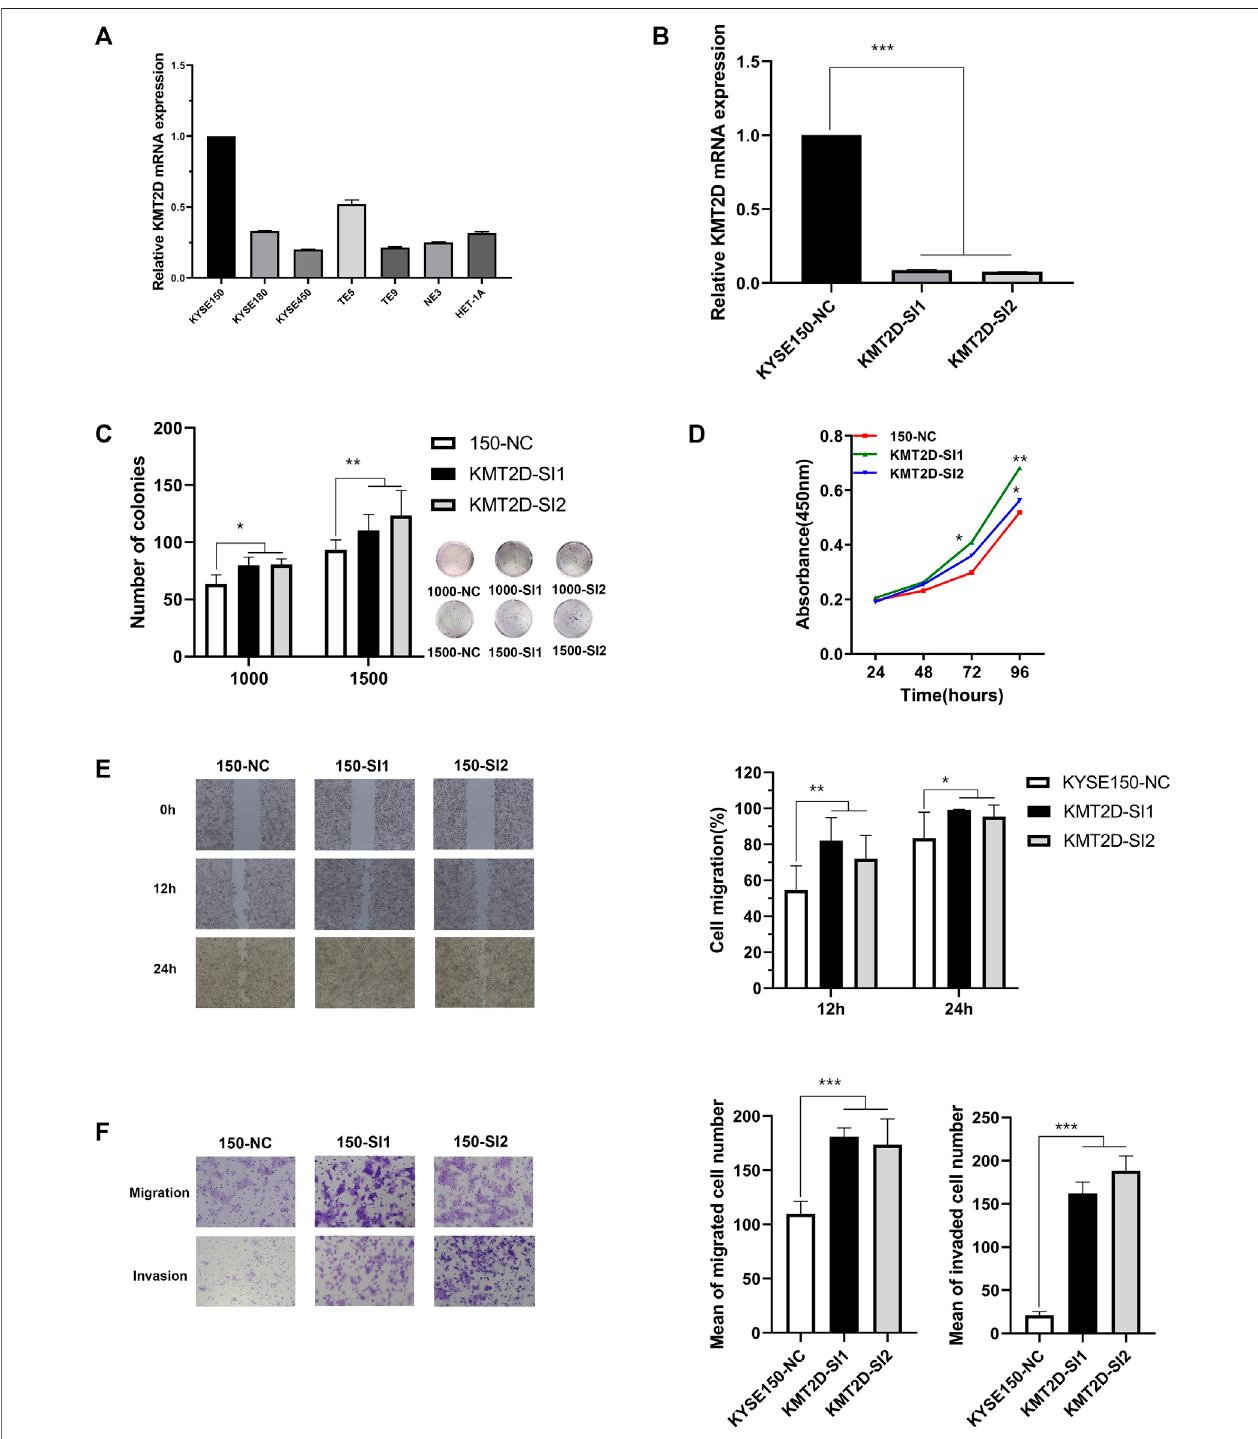
FIGURE 8 | The effect of KMT2D in KYSE150 cell line. (A) The mRNA expression of KMT2D in normal esophageal epithelial cell lines and ESCC cell lines detected byq-RTPCR, (B) Theknockdownef fi ciencyof KMT2D inKYSE150celllinewasveri fi edbyq-RTPCR, (C) KMT2D knockdownpromotedtheabilityofcolonyformationin KYSE150 cell line compared to the control, (D) KMT2D knockdown promoted the ability of proliferation in KYSE150 cell line compared to the control, (E) KMT2D knockdownpromotedtheabilityofmigrationinKYSE150celllinecomparedtothecontrol, (F) KMT2D knockdownpromotedtheabilityofmigrationandinvasionin KYSE150 cell line compared to the control. All data are presented as the mean ± standard deviation of the three in-dependent experiments.